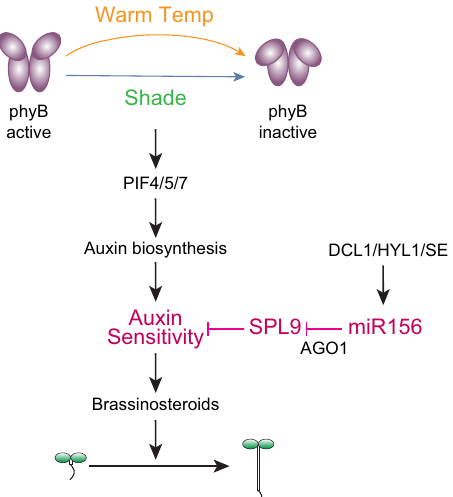
Fig. 7 | Model for miR156-enabled phenotypic plasticity to temperature and light changes. Environmental light and temperature changes perceived by the photoreceptor and thermosensor PHYB trigger profound modulations in plant architecture viathe mastergrowthregulatorsPIFs and PIF-induced auxinsynthesis and signaling. This study unveils a previously unknown control of auxin sensitivity licensedbymiR156.AuxinsensitivityisantagonizedprimarilybySPL9.Inlight-and temperature-elicited hypocotyl elongation responses during Arabidopsis seedling establishment, miR156 enables auxin sensitivity by repressing SPL 9. We propose that miR156-dependent auxin sensitivity constitutes a genetic circuit gating light and temperature responses by the endogenous developmental program. This cri- ticalroleofmiR156makesthebasiccomponentsinvolvedinmiRNAbiogenesisand function, such as DCL1, HYL1, SE, and AGO1, necessary elements for the plant ’ s